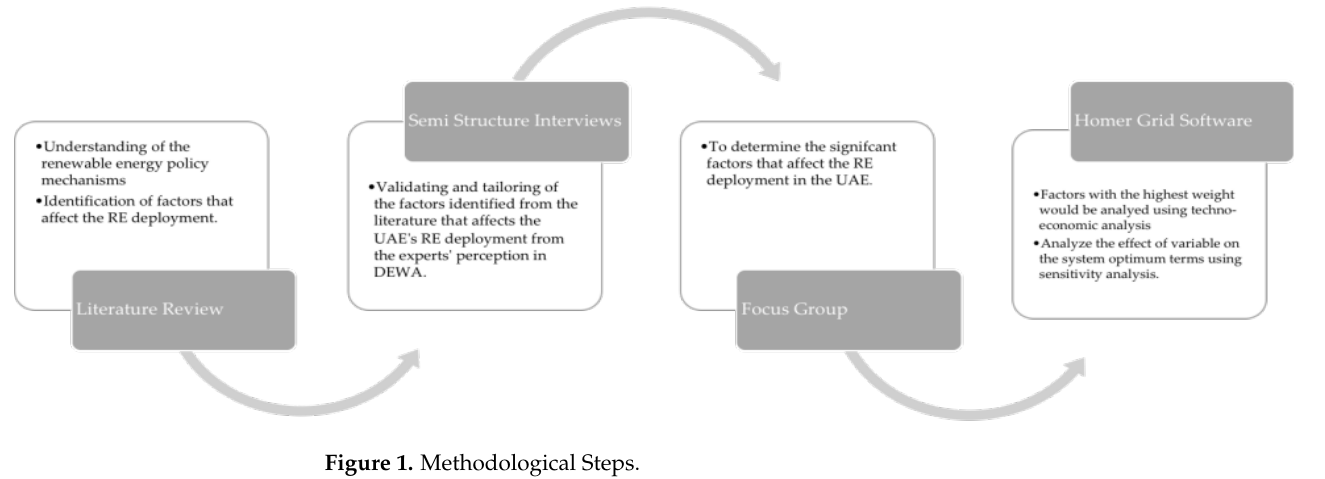
Figure 1. Methodological Steps.